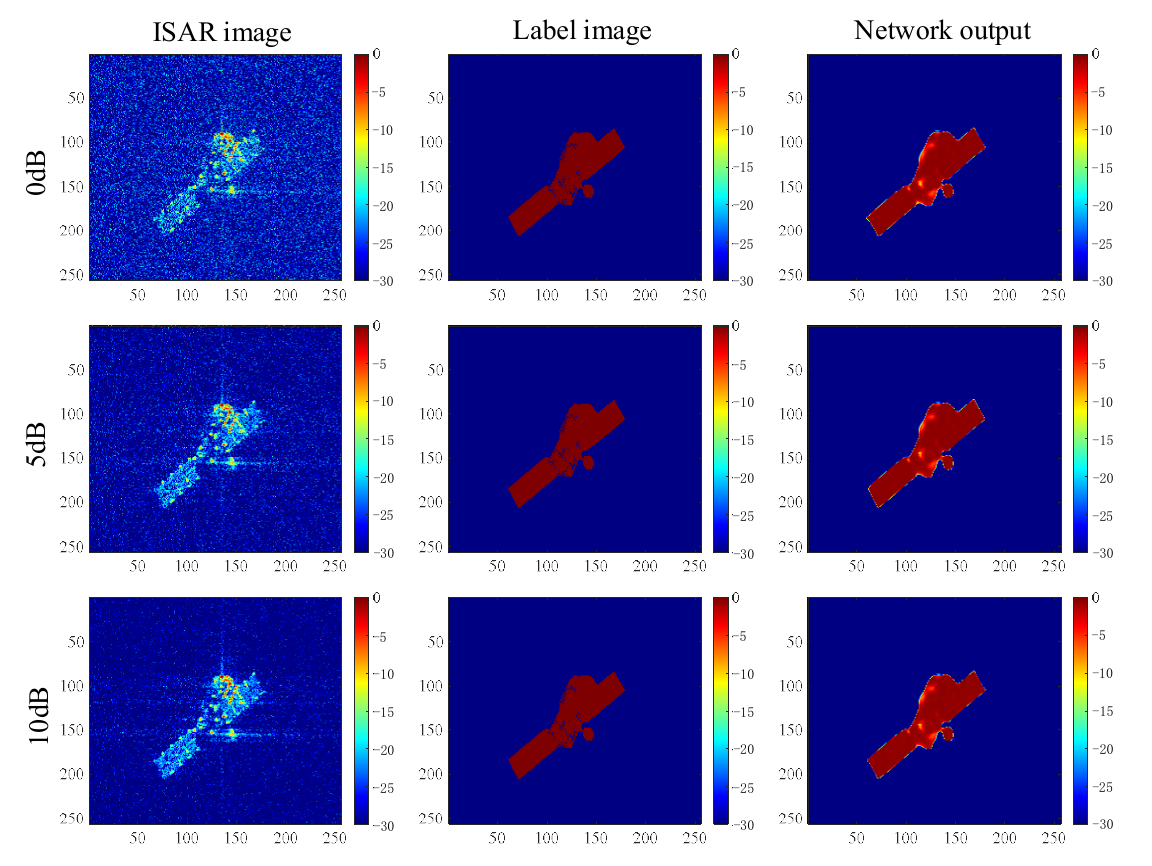
Figure 12. The imaging results of test data 3 under different SNRs. Table 8. The Euler angle estimation results of test data